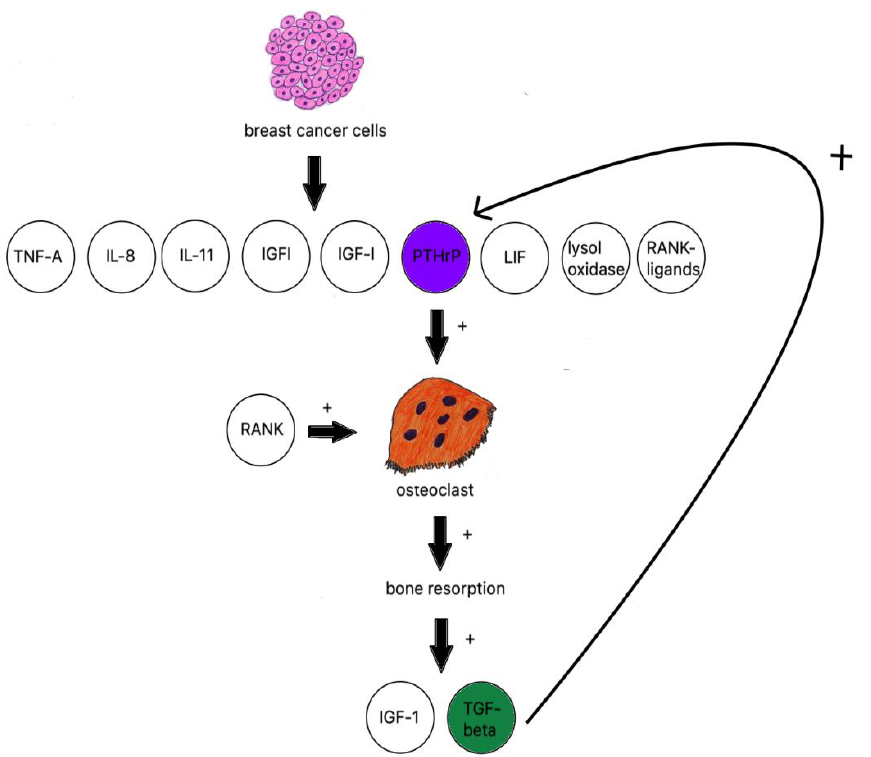
Figure 2. Breast cancer influence on osteoclastogenesis.